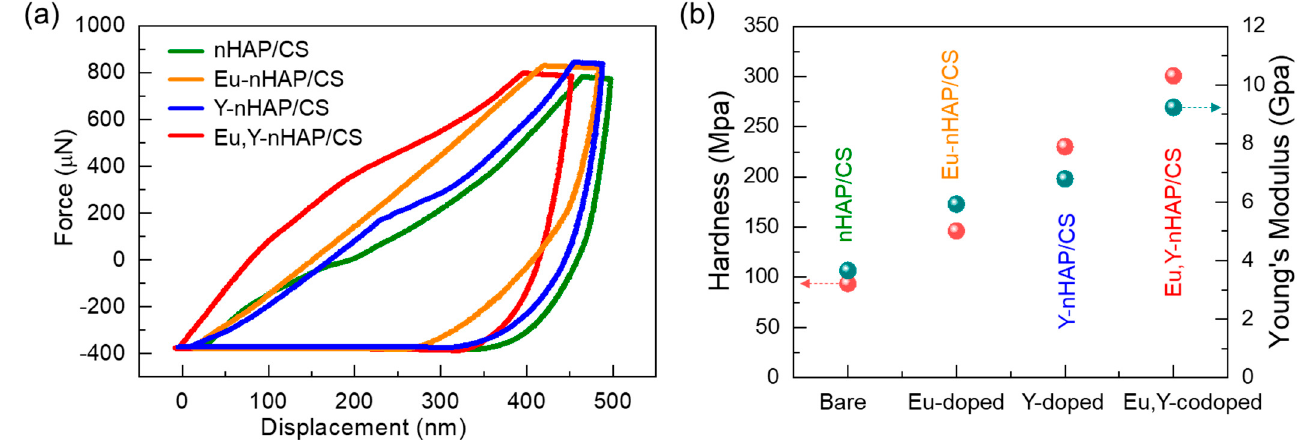
Figure 5. ( a ) Load–displacement indentation curves of the nHAP/CS, Eu-nHAP/CS, Y-nHAP/CS,